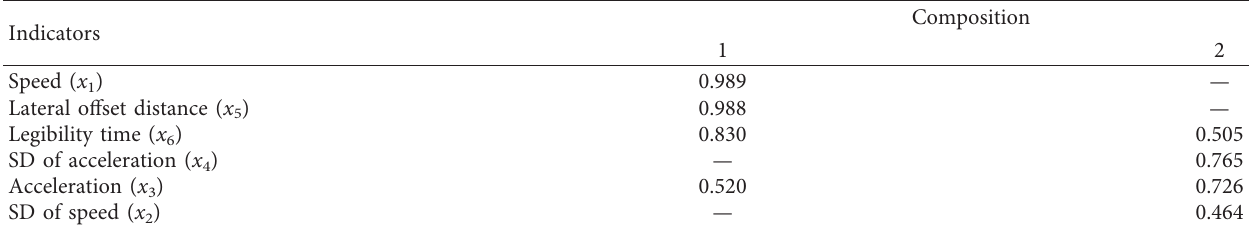
Figure 7: Gravel figure. Table 6: Factor loading